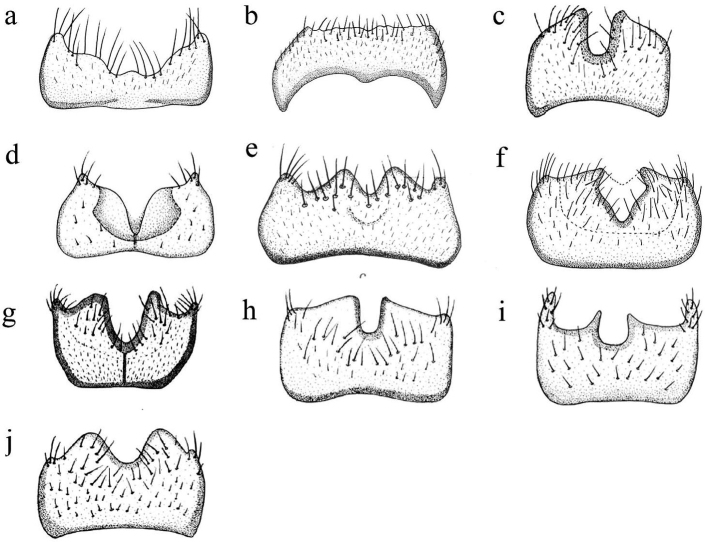
Sternite 9 of Coniopteryx species, ventral view aC.
qionganabC.
unguigonarcuatacC.
wuyishanadC.
aliferaeC.
pygmaeafC.
chouigC.
plagiotropahC.
compressaiC.
exiguajC.
guangxiana.